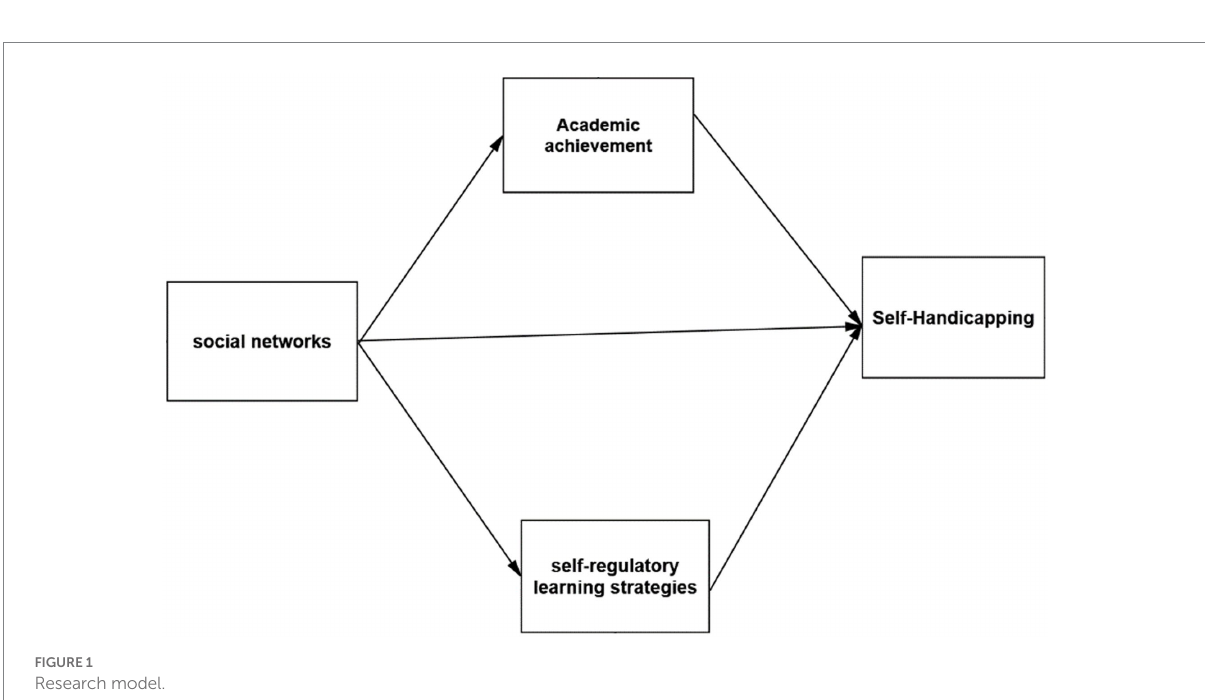
FIGURE 1 Research model.